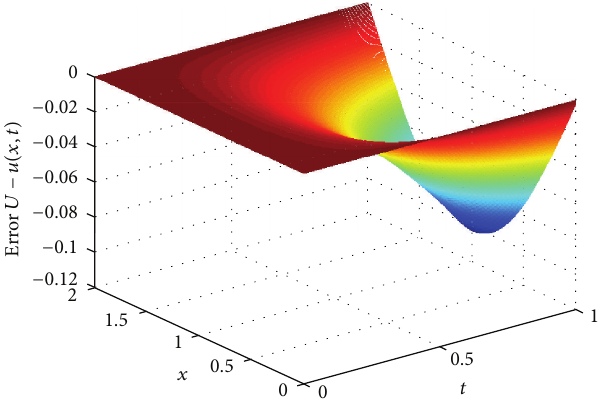
Figure 3: The error of the analytical solution and the numerical solution for 𝛼 = 1.5 by Numerical Algorithm I (see (38)) with 𝜏 = 0.0025, ℎ = 0.01 .